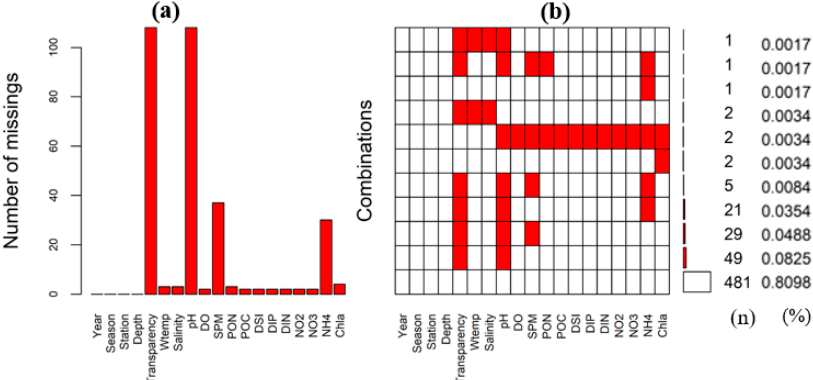
Figure 5. Missing data pattern of experiment data ( n = 594). Number of missings ( a ); Combinations ( b ).